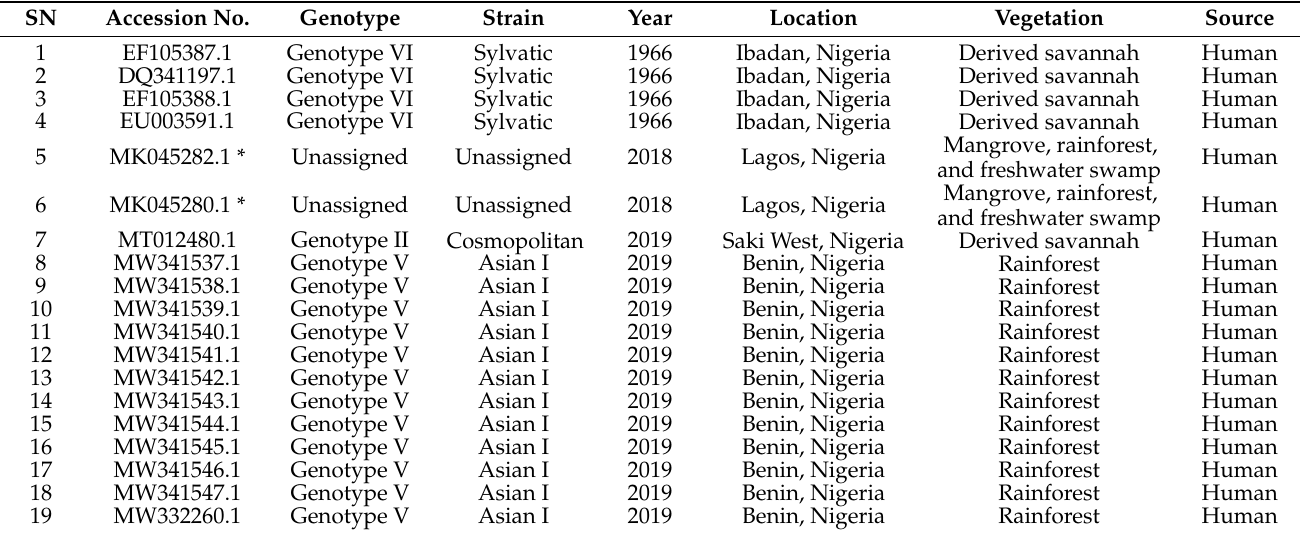
Table 1. List of dengue virus serotype 2 obtained in Nigeria from 1966–2019.